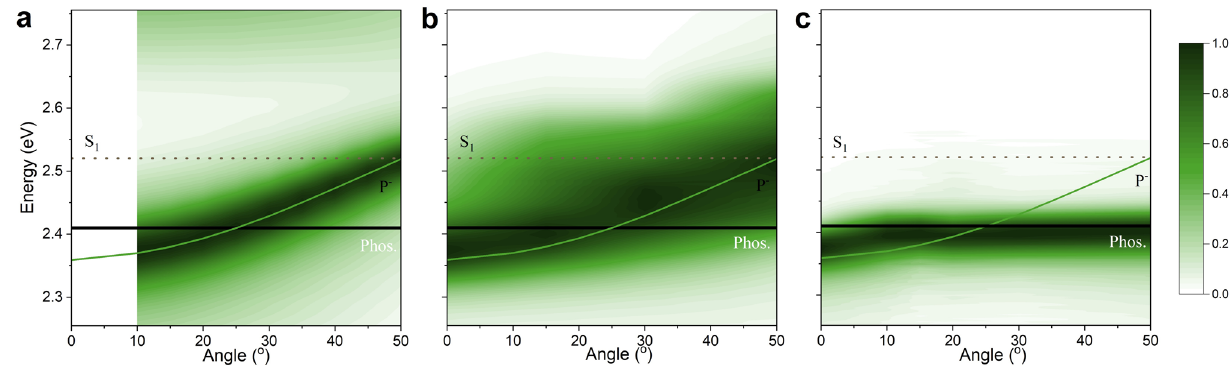
Fig. 5 The crossing point between polariton emission and phosphorescence. a – c Angle dependent absorption (1-re fl ectance) ( a ), angle dependent prompt emission at room temperature ( b ), and angle dependent delayed emission at 77 K ( c ) of a cavity having similar parameters as Cavity 3. Fluorescence (dotted lines), phosphorescence (black solid lines), and fi tted P – energy (green solid lines) are indicated. It should be noted that the excitation angle could not be held constant when performing angular dependent delayed emission experiments at 77 K. The emission dispersion plot in c is therefore normalized, with the consequence that information on the relative intensity of emission as a function of angle is